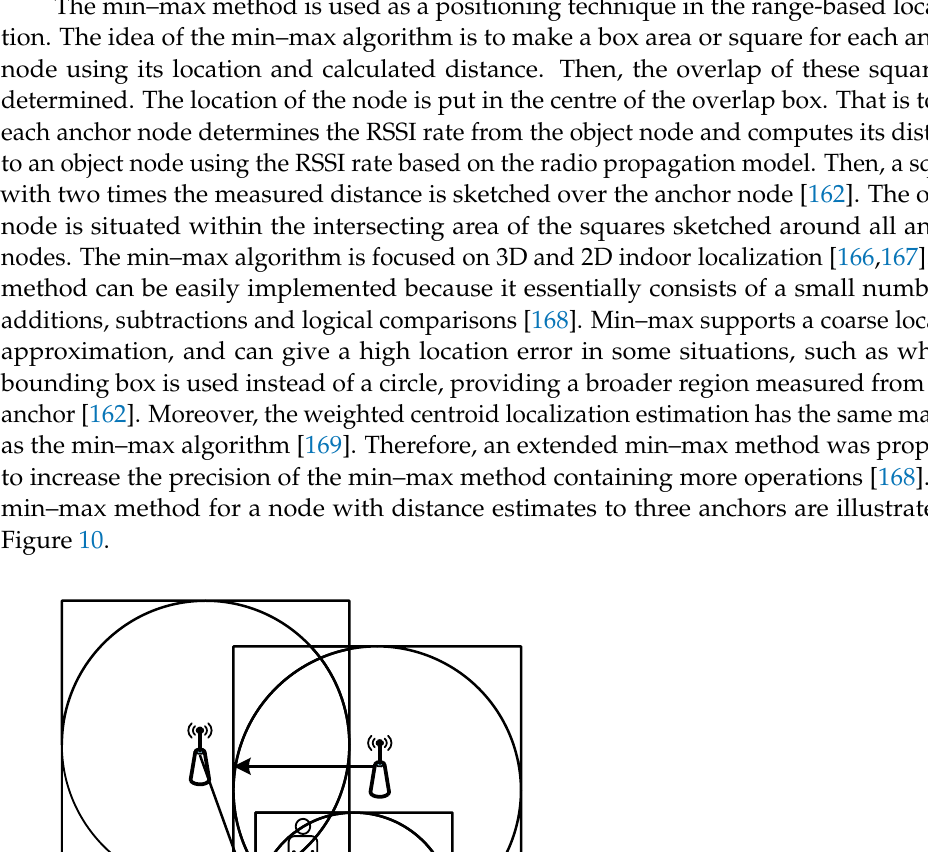
Figure 10. Min–max ‐ based positioning method. Figure 10. Min–max-based positioning